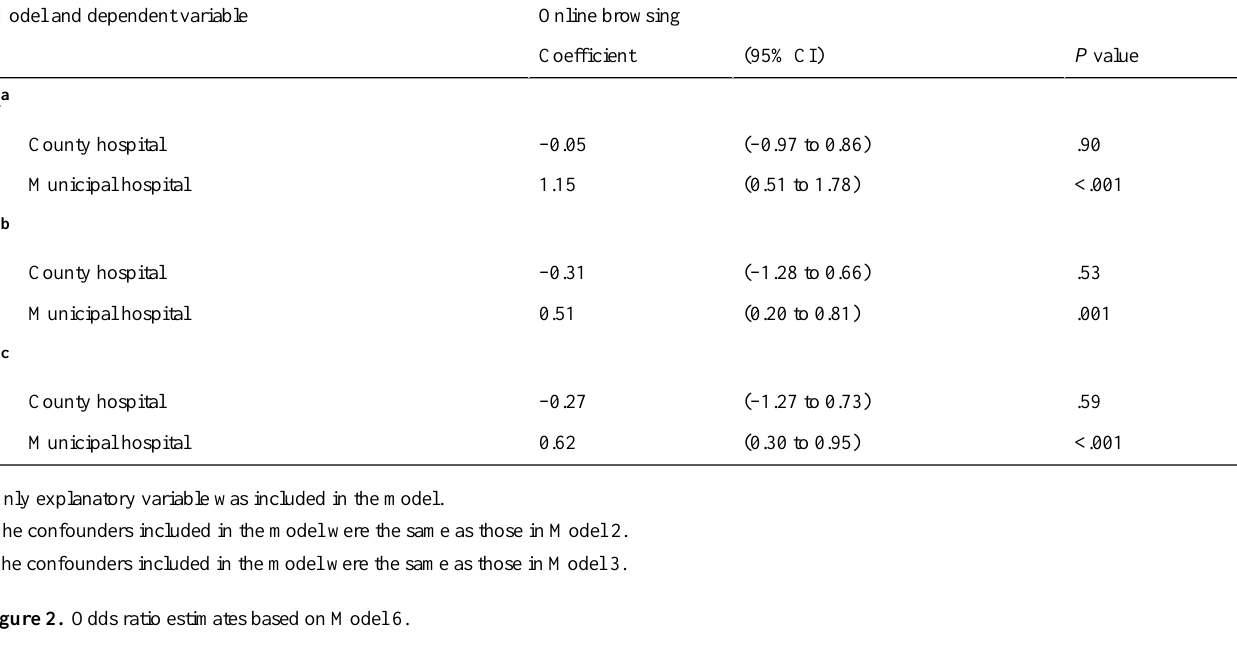
Table 6. Results of generalized linear mixed-effects multinomial logit model analyzing the influence of online browsing on medical provider choice (ref=primary hospital).